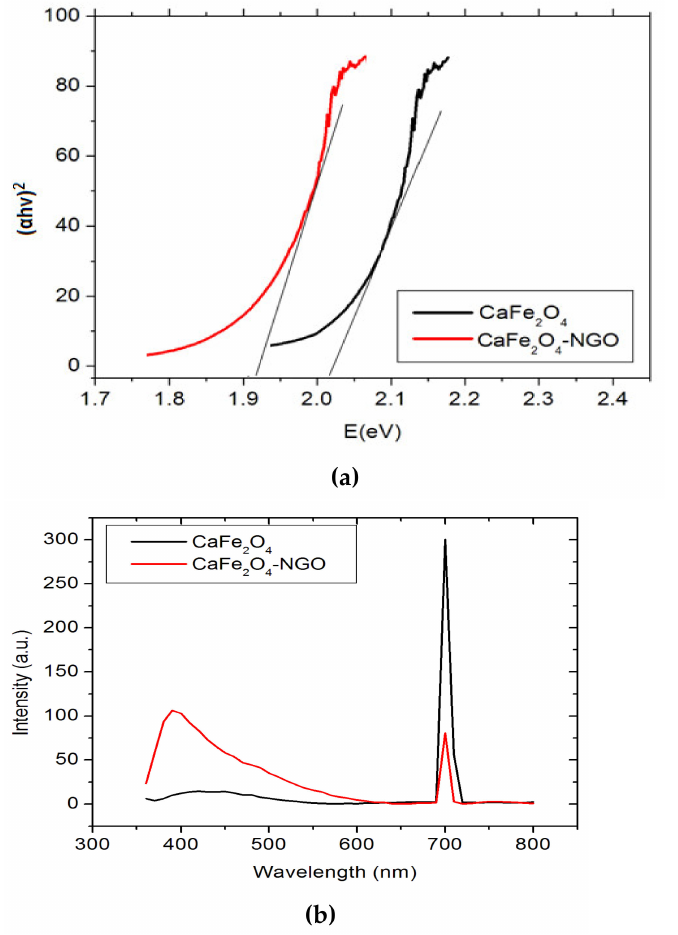
Figure 6. ( a ) Tauc plot of CaFe 2 O 4 and CaFe 2 O 4 -NGO and ( b ) photoluminescence spectra of CaFe 2 O 4 and CaFe 2 O 4